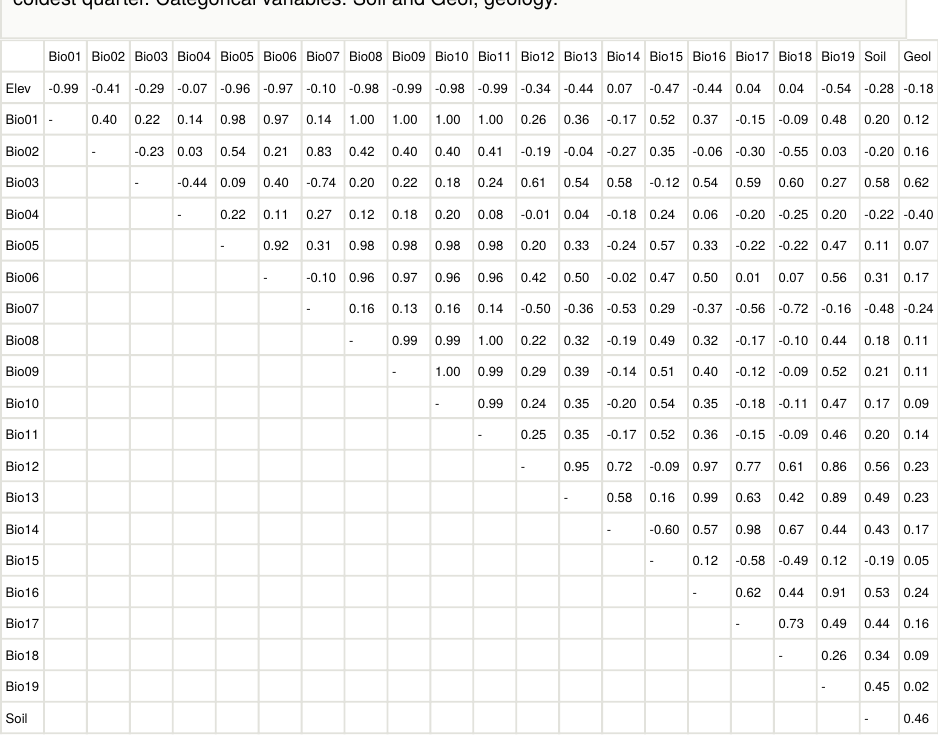
(precipitation in the driest month) belonged to the same group, they were not highly correlated with each other, so both were retained for further analyses, in addition to elevation and Bio07 (annual temperature range). Correlations of variables Bio03 (isothermality), Bio04 (temperature seasonality), Bio15 (precipitation seasonality), Bio18 (precipitation in the warmest quarter), soil and geology were below 0.75 in all cases and thus included in the modelling process. Table 1. Pearson's correlations between continuous environmental variables, polyserial correlations between continuous and categorical environmental variables and polychoric correlations between the categorical environmental variables for the record localities of Lesbia nuna in Colombia. Continuous variables: Elev, elevation; Bio01, annual mean temperature; Bio02, mean monthly temperature range; Bio03, isothermality; Bio04, temperature seasonality; Bio05, max temperature of the warmest month; Bio06, min temperature of the coldest month; Bio07, temperature annual range; Bio08, mean temperature of the wettest quarter; Bio09, mean temperature of the driest quarter; Bio10, mean temperature of the warmest quarter; Bio11, mean temperature of the coldest quarter; Bio12, annual precipitation; Bio13, precipitation of the wettest month; Bio14, precipitation of the driest month; Bio15, precipitation seasonality; Bio16, precipitation of the wettest quarter; Bio17, precipitation of the driest quarter; Bio18, precipitation of warmest quarter; Bio19, precipitation of the coldest quarter. Categorical variables: Soil and Geol,